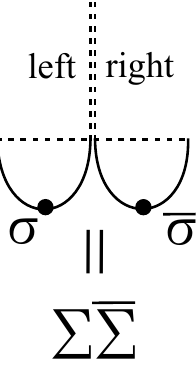
Figure 4 . Surface state representing the (reverse) product (cid:6)(cid:6). Note that the boundary condition changing insertions are well-separated. This surface can be seen to de(cid:12)ne a star algebra projector following the arguments given in